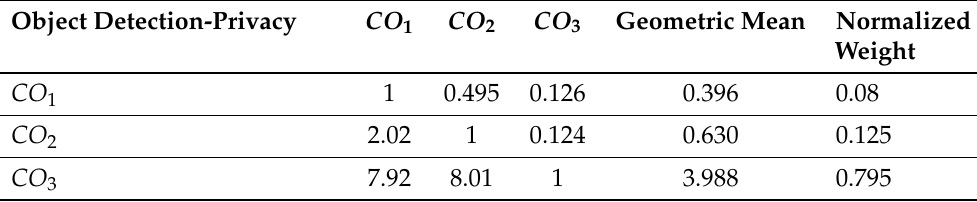
Table 10. Comparison between suitable components for object detection with respect to privacy.